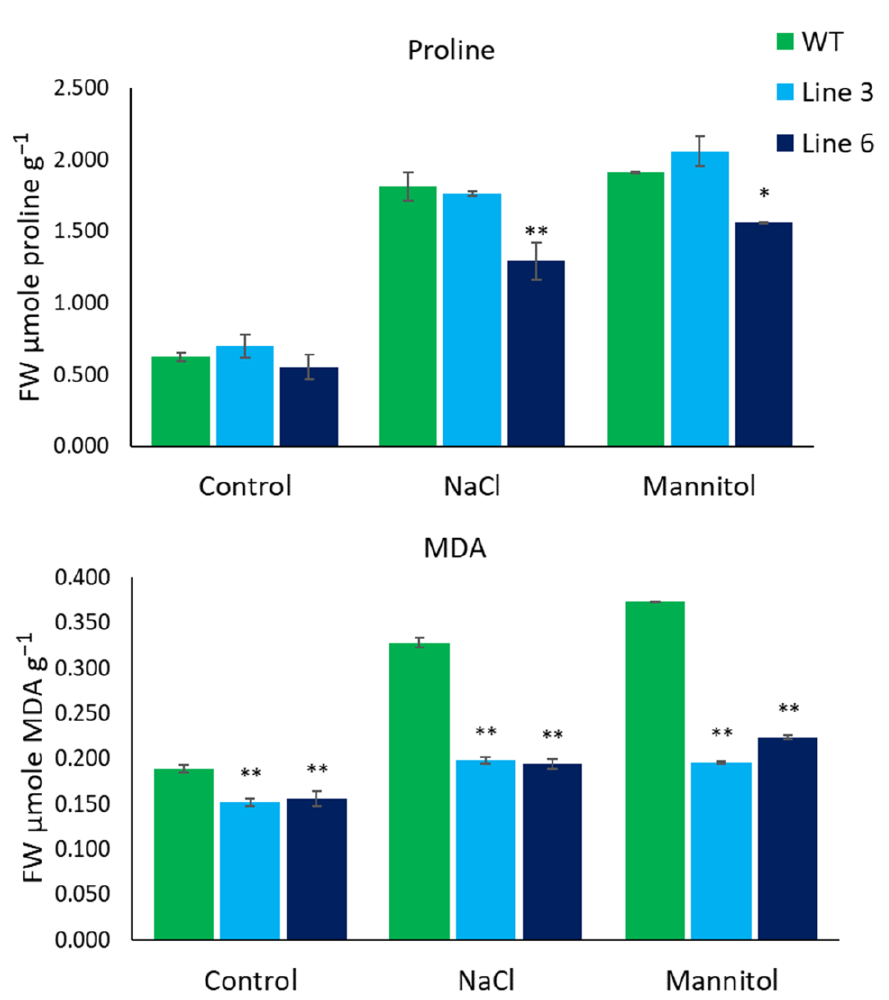
Figure 7. Comparative analysis of proline and MDA content in WT and SIACO2 mutant lines under control, 200 mM NaCl, and 200 mM mannitol treatments from 10 weeks old leaves. Results represent mean values; error bars indicate the ± standard error (n = 3 replicates). Single asterisks indicate statistically significant differences ( p < 0.05), and double asterisks represent a very significant difference ( p < 0.01) according to ANOVA (IBM, SPSS 26).